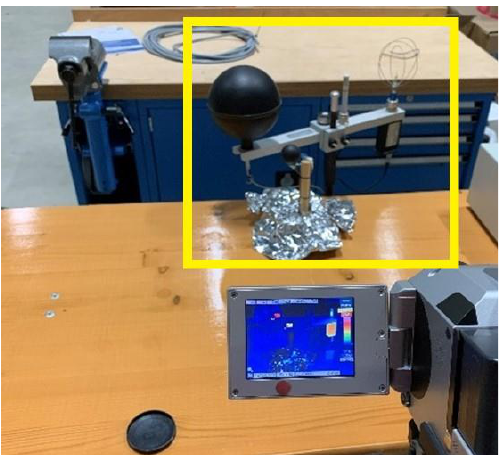
Figure 2. Testing configuration with the prototype base covered by aluminium foil.